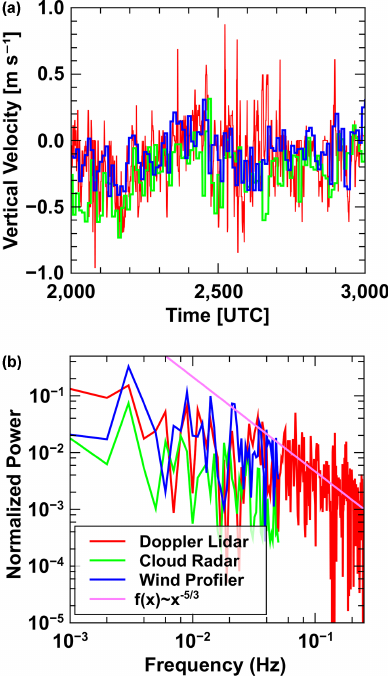
Figure 9. The vertical velocities (a) and their power spectra (b) are shown, taken at the red lines indicated in Fig. 8. It is clearly visible that only the Doppler lidar is able to sense the inertial subrange, where its power spectrum is close to the f − 5 / 3 line. The advantage of the Doppler lidar is also visible in (a) , where fast changes of vertical velocity on time scales smaller than 10s are visible only in the Doppler lidar measurements (red).